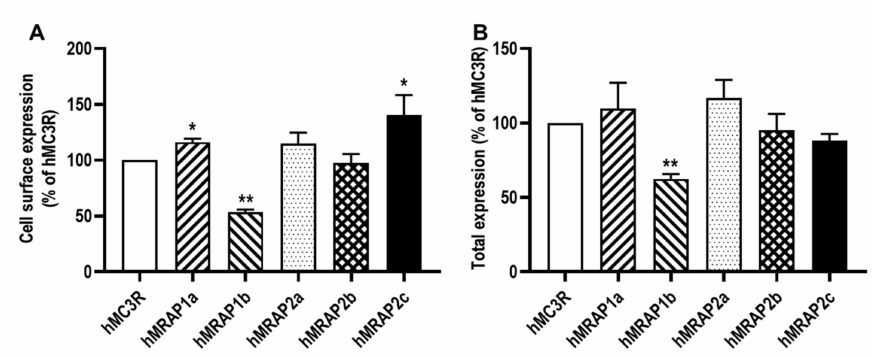
Figure 2. Regulation of hMC3R expression by hMRAP1s or hMRAP2s. Cell surface ( A ) and total ( B ) expression of hMC3R were measured by flow cytometry. HEK293T cells were co-transfected with hMC3R and hMRAP1s or hMRAP2s. Fluorescence in cells transfected with empty vector pcDNA3.1